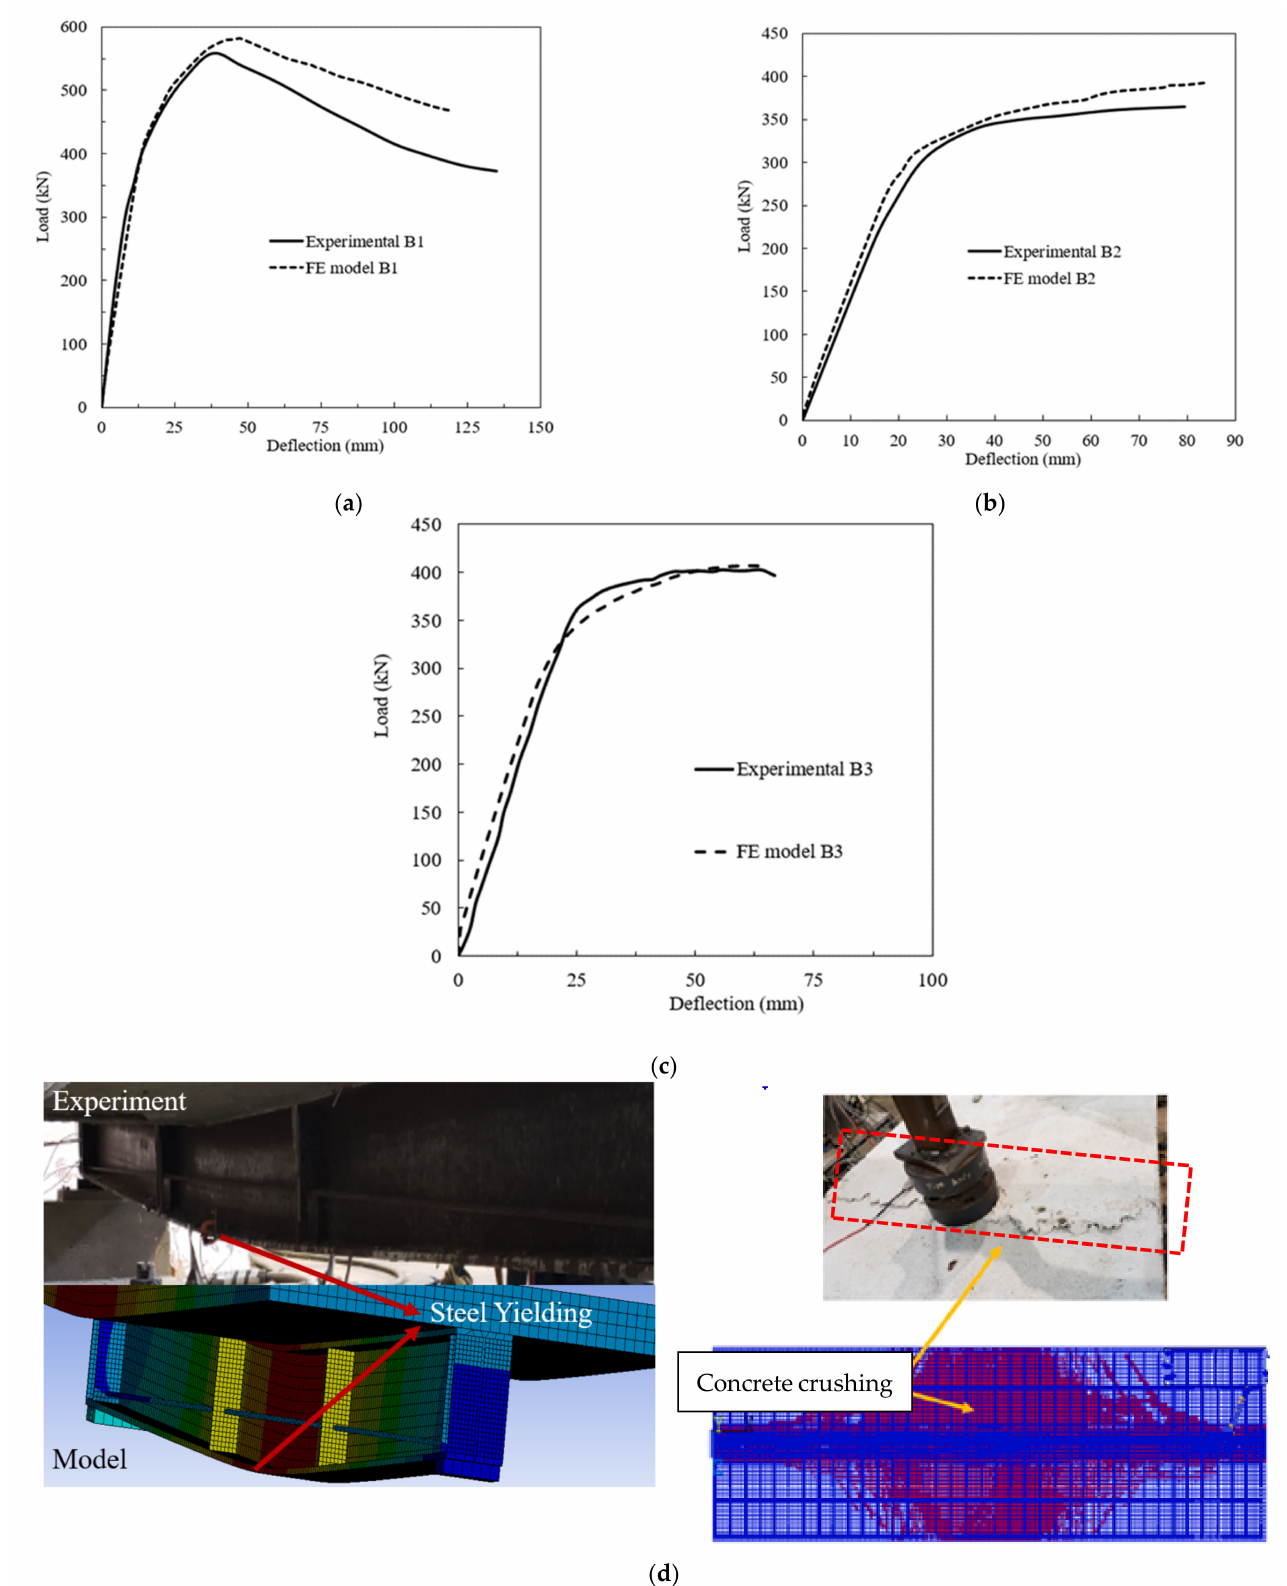
Figure 4. Comparisons of the FE and experimental results for the load-deflection curves. ( a ) Beam B1. ( b ) Beam B2. ( c ) Beam B3. ( d ) Steel yielding and concrete crushing captured by the FE model for